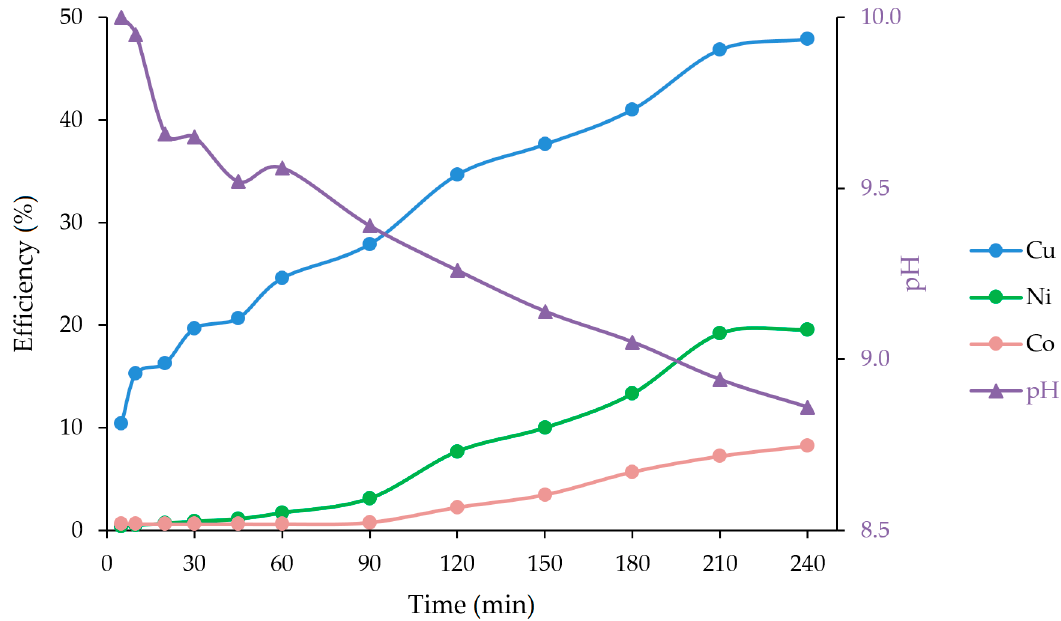
Figure 2. Kinetics of metals extraction during ammoniacal leaching at 50 °C.